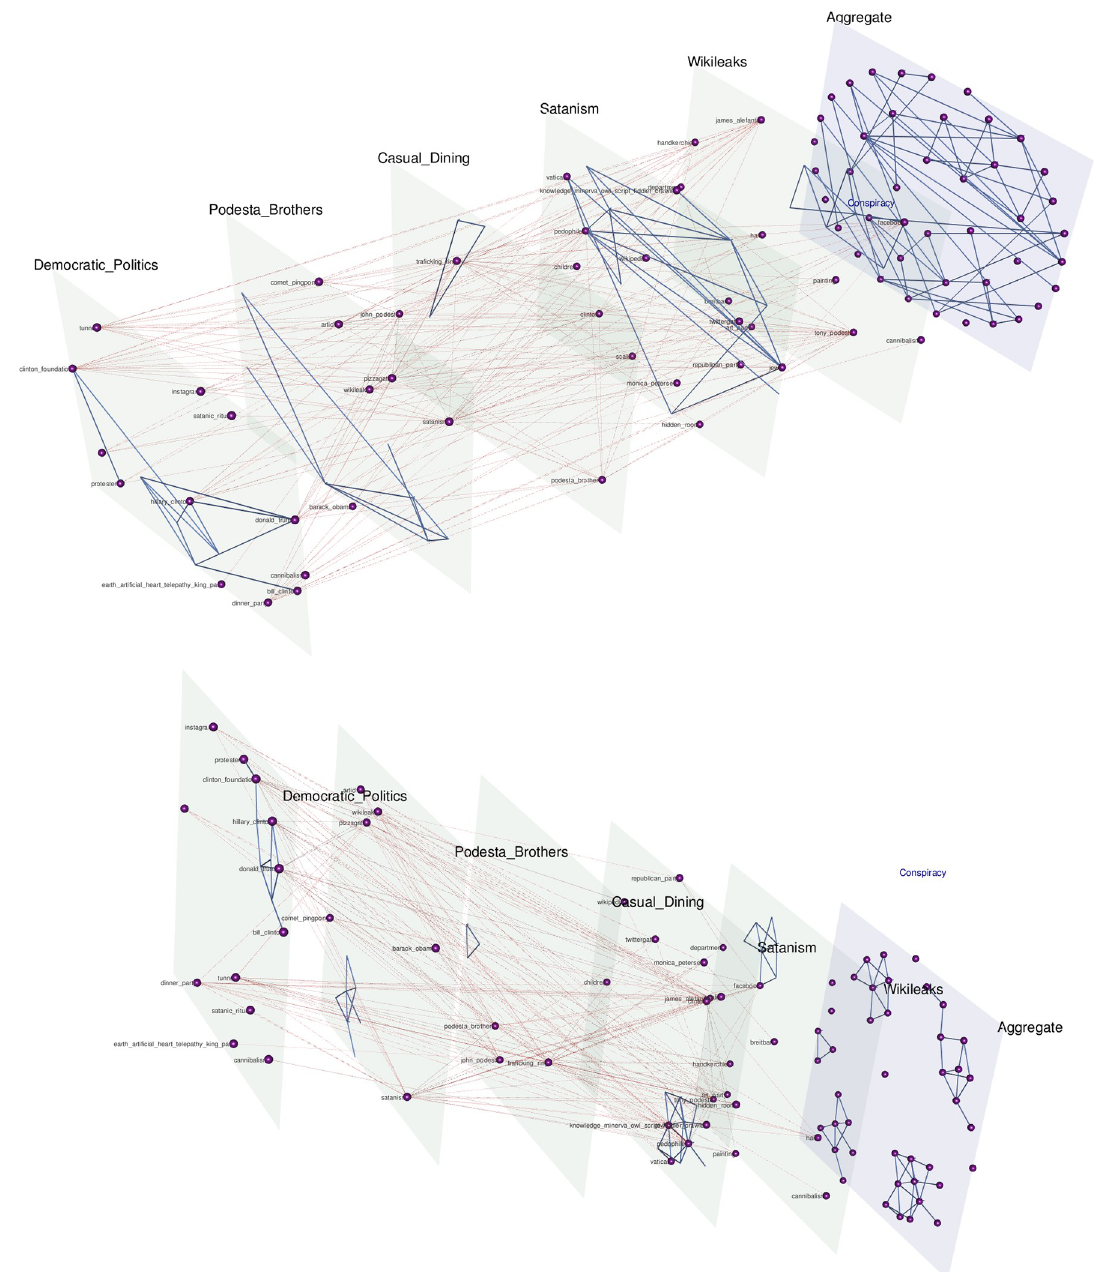
Fig 9. A three dimensional visualization of the narrative framework for Pizzagate in terms of domains. On the top, A: the graph with the inclusion of relationships generated by Wikileaks—the aggregate graph in blue shows a single large connected component. On the bottom, B: the graph with the Wikileaks relationships removed, shows on the aggregate level the remaining domains as disjoint components. In the Pizzagate conspiracy theory, the different domains have been causally linked via the single dubious source of the conspiracy theorists’ interpretations of the leaked emails dumped by Wikileaks. No such keystone exists in the Bridgegate narrative Network.